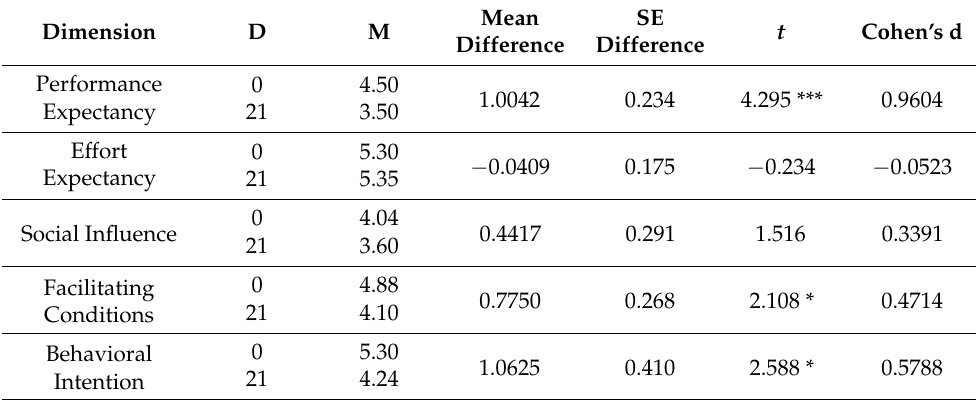
Table 6. Evolution of the average dimensions of the UTAUT between D0 and D + 21 SHERPAM project ( t -Test Sample